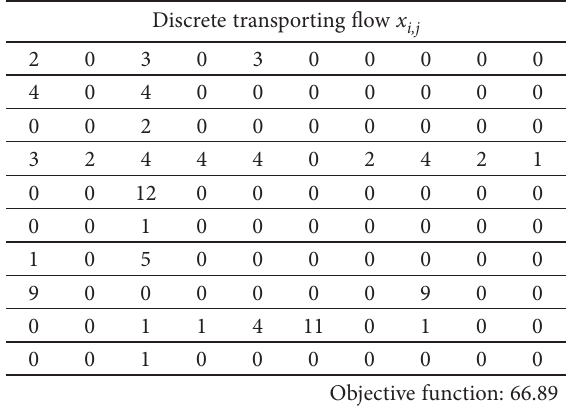
Table 7. Best obtained discrete solution for the 10×10 test problem with cost function B Discrete transporting flow x